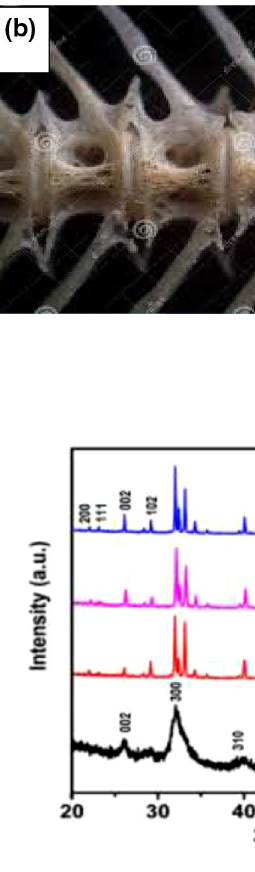
Fig. 7 The XRD pattern HAp at different sintering temperatures